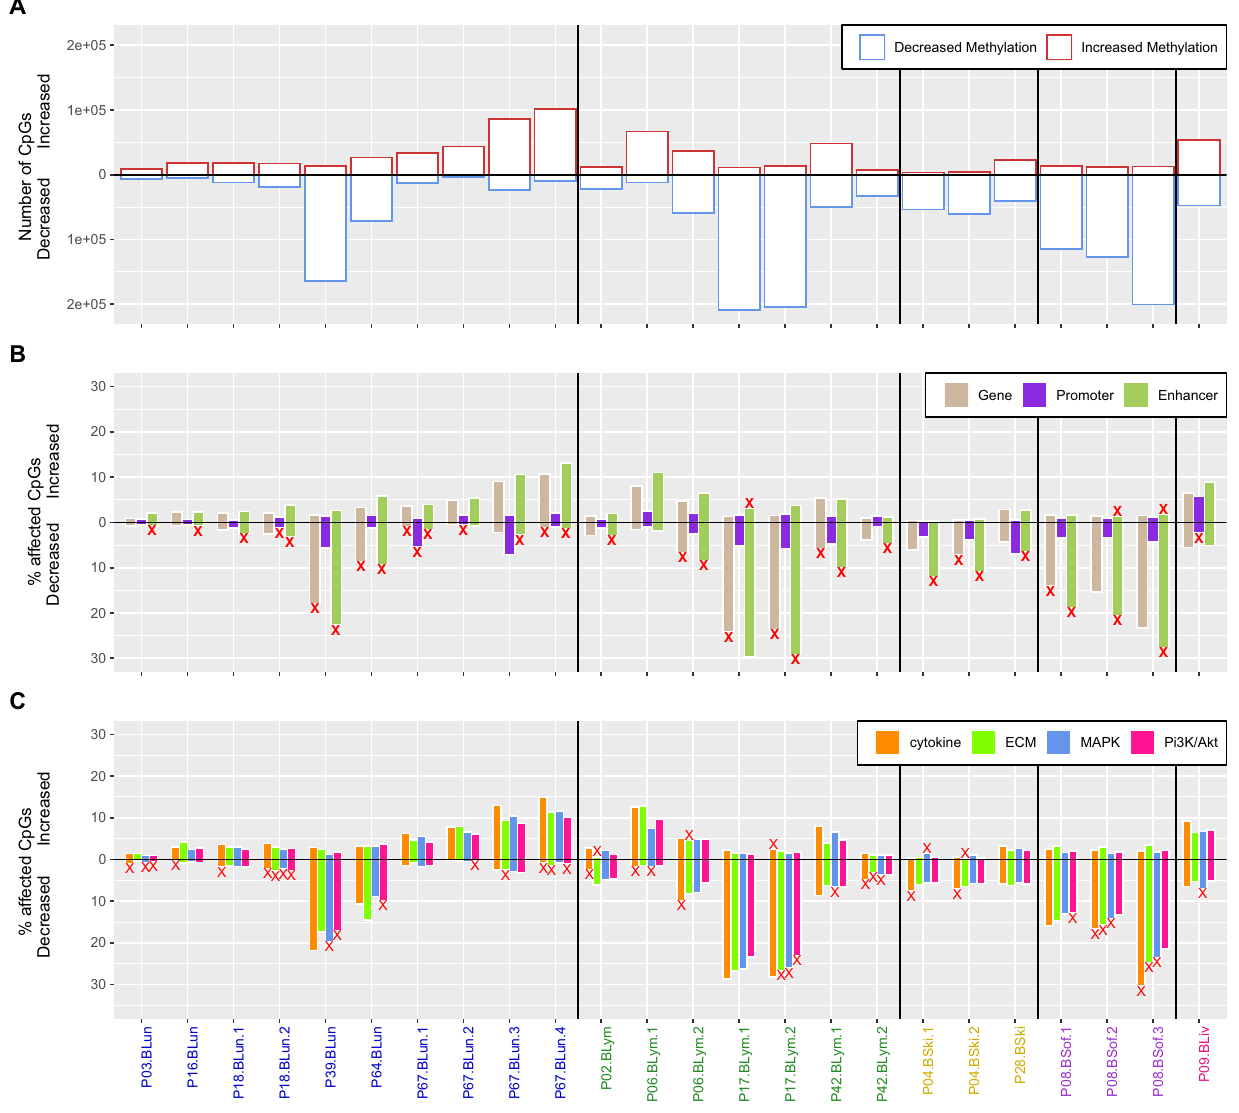
Figure 3. Overview of methylation changes of individual metastases pairs. Patient-specific summary of the HMM-based predictions of the methylation states of individual CpGs. The patient-specific metastases pairs are sorted by the tissue in which the extracranial metastasis occurred (x-axis) with brain versus lung (blue), brain versus lymph node (green), brain versus skin (yellow), brain versus soft tissue (purple), and brain versus liver (pink). ( A ) Total number of differentially methylated CpGs predicted to have a decreased (blue, downward bars from 0) or increased (red, upward bars from 0) methylation in the corresponding patient-specific metastases pair. ( B ) Percentage of CpGs with decreased or increased methylation located in functional genomic elements with a focus on gene bodies, promoters and enhancers for each metastases pair. ( C ) Percentage of increased and decreased methylated CpGs of the most frequently affected signaling pathways. Significant enrichment of a genomic category is marked with a red ‘x’ in subpanels ( B ) and ( C ) (FDR-adjusted p value <